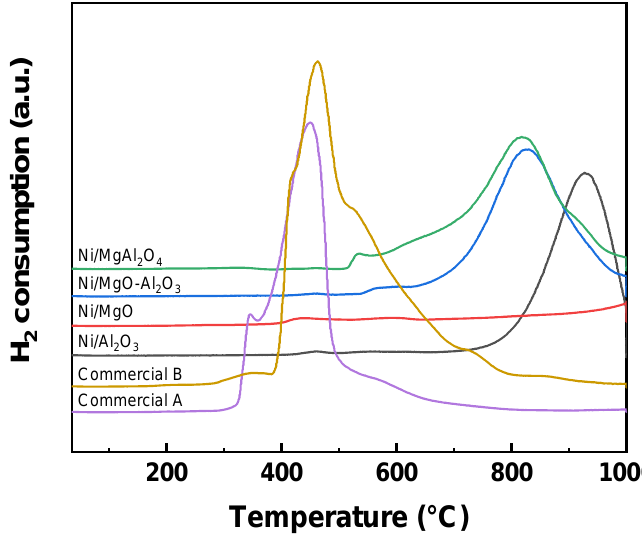
Figure 2. H 2 -TPR profiles of Ni catalysts with various supports.